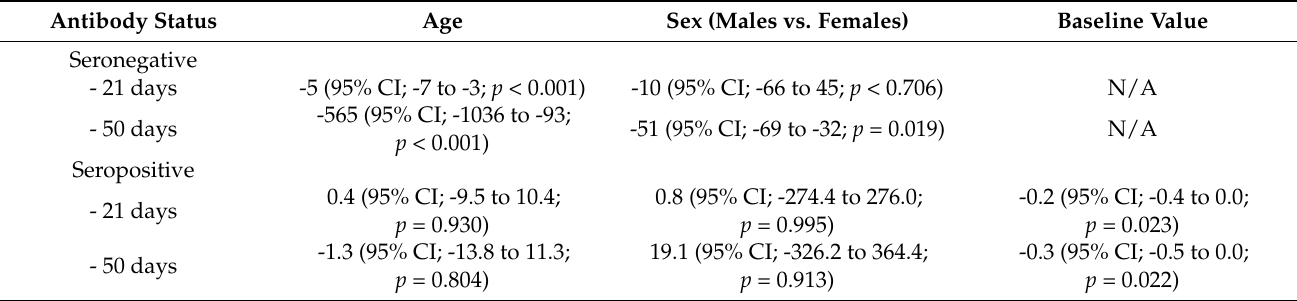
Table 3. Multivariate analysis (beta coefficient and 95% CI) of the ratio of increase from individual baseline total anti-SARS- CoV-2 RBD antibodies level and age, sex or baseline antibodies value in baseline seronegative (<0.8 U/L) and baseline seropositive ( ≥ 0.8 U/L) subjects receiving a complete cycle (i.e., two doses) of Pfizer COVID-19 mRNA BNT162b2